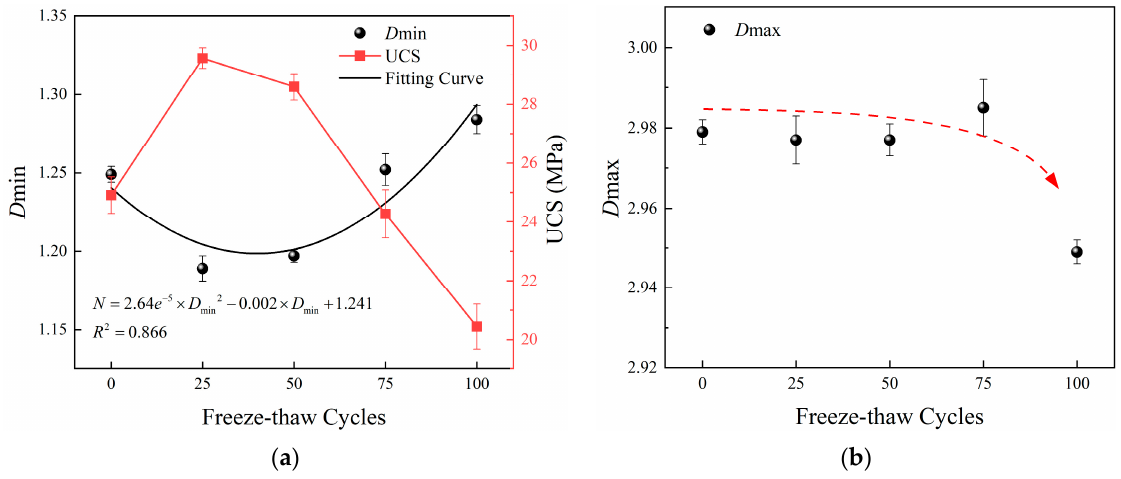
D and min and D max under freeze-thaw cycles. ( a ) D min ( b ) D max min